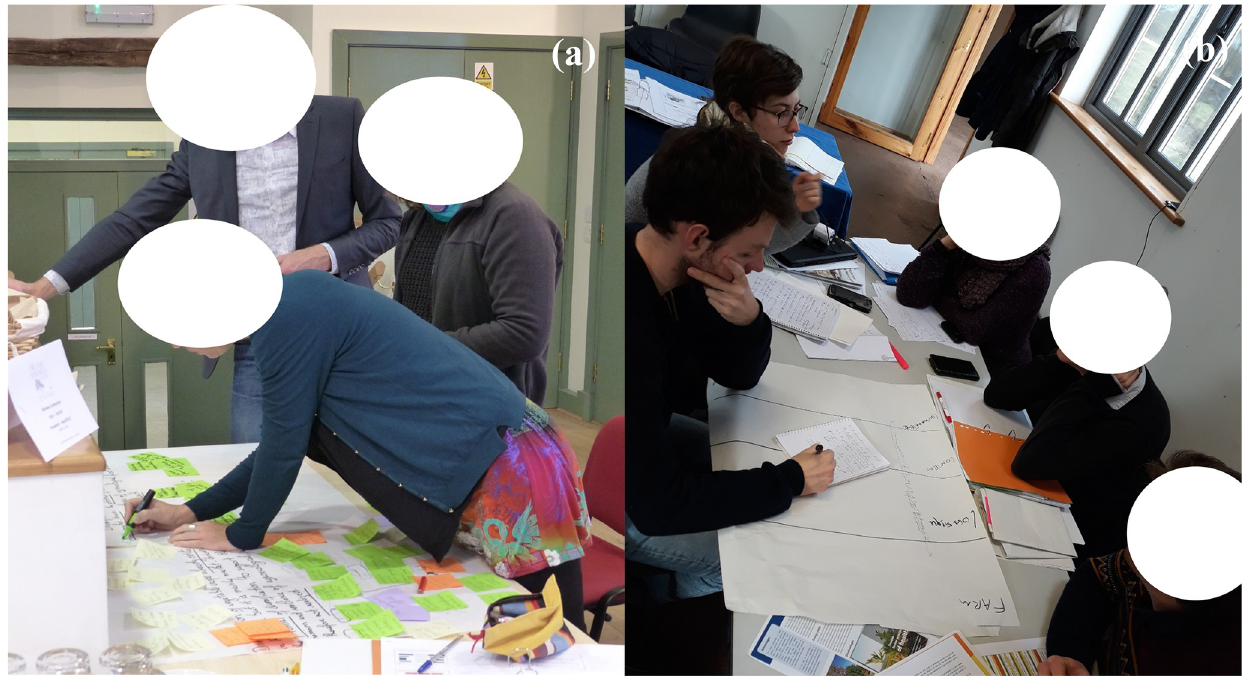
Fig 3. An innovation team brainstorming on a “problem tree” in the first-round workshop (a) and a complementary interview in the second-round workshop(b). Each innovation team consists in 2 participants (case leader and monitor). Additional persons are scientists facilitating the process or carrying out the interview. The individuals appearing here gave us written informed consent (as outlined in PLOS consent form) to publish these case